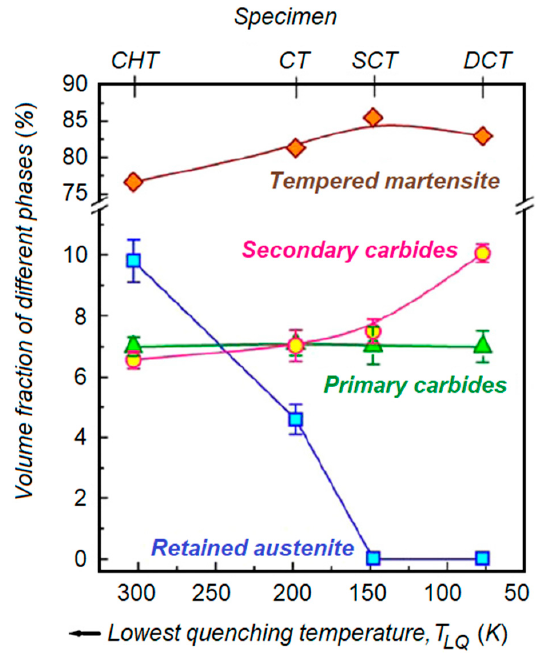
Figure 8. Variation of number of different phases with lowest quenching temperature (TLQ) [68].